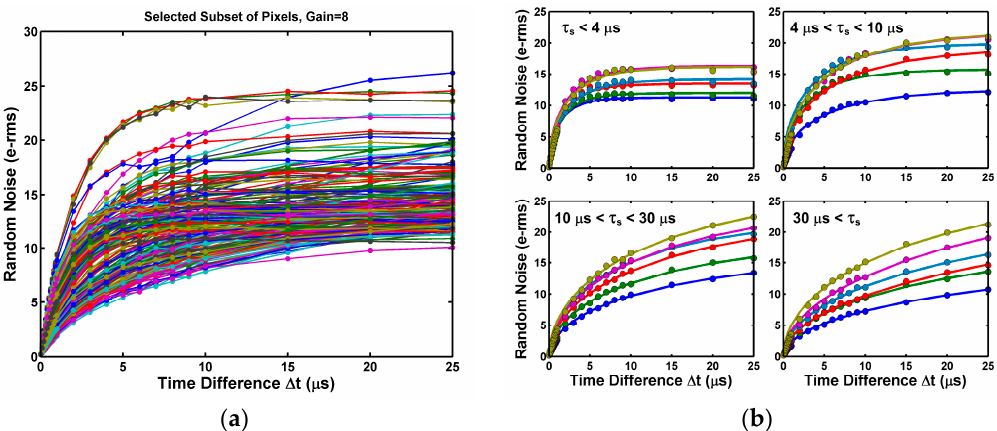
Figure 14. ( a ) The RN evolution from Δ t = 0 (correlated double sampling) to Δ t = 25 μ s (uncorrelated double sampling) for a selected subset of 200 pixels; ( b ) Examples of pixels groups with various ranges of time constants from 1 μ s to 500 μ s. of time constants from 1 µ s to 500 µ s.